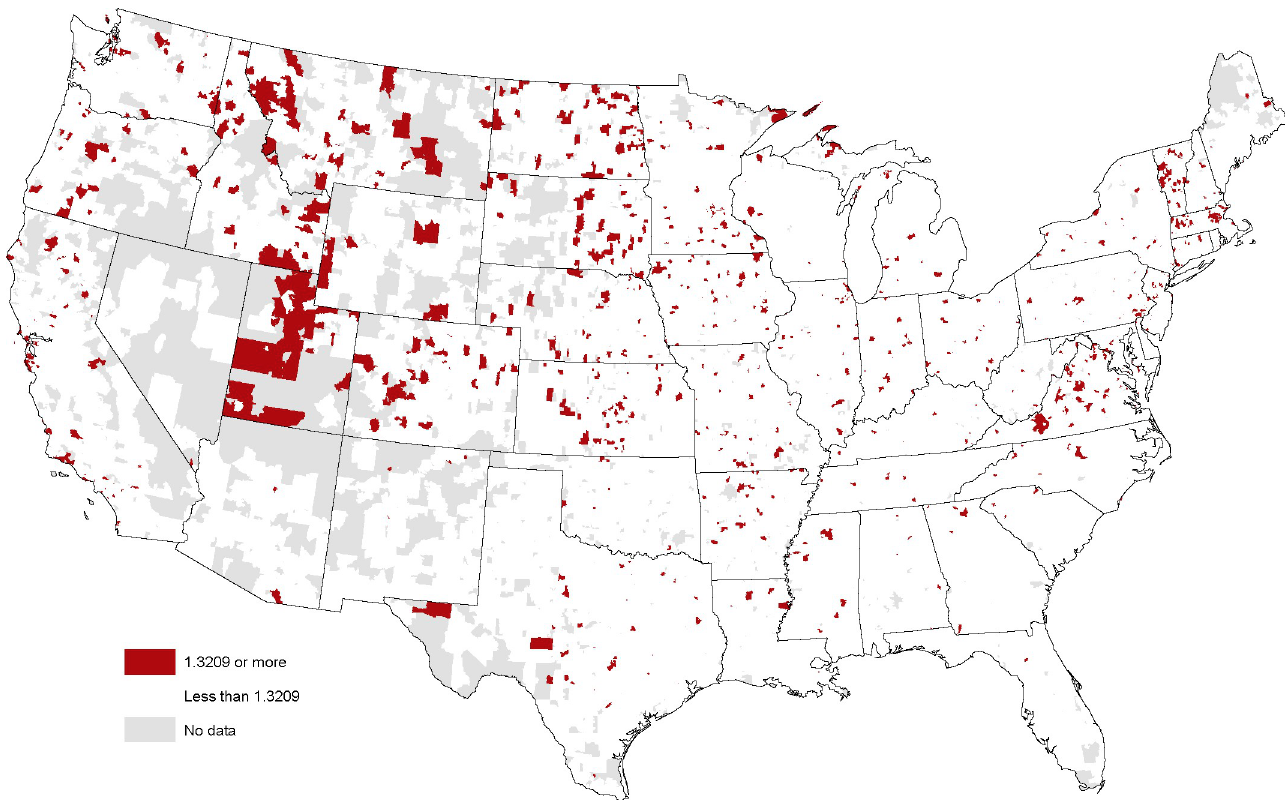
Fig 2. Arts avocation hotspots (index > 1. 32) mapped at ZIP code level, January 2018. Sources: Esri, DStillery Custom Crafted Audience. Maps were created using ArcGIS 1 software by Esri. ArcGIS 1 and ArcMap ™ are the intellectual property of Esri and are used herein under license. Copyright Esri. All rights reserved. For more information about Esri 1 software, please visit